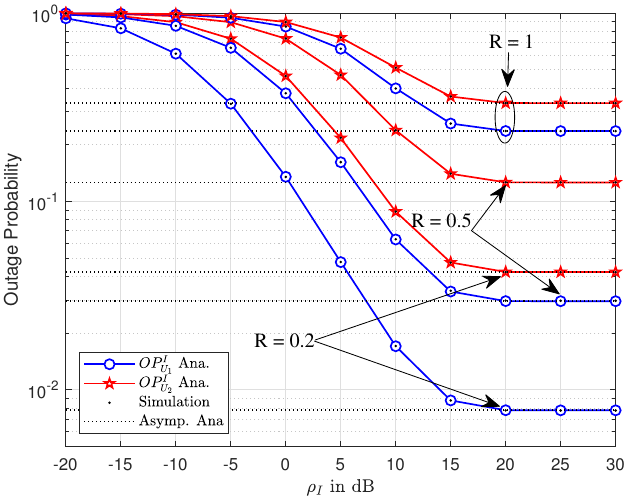
Figure 3. Outage performance of U 1 and U 2 versus ¯ ρ S as varying R